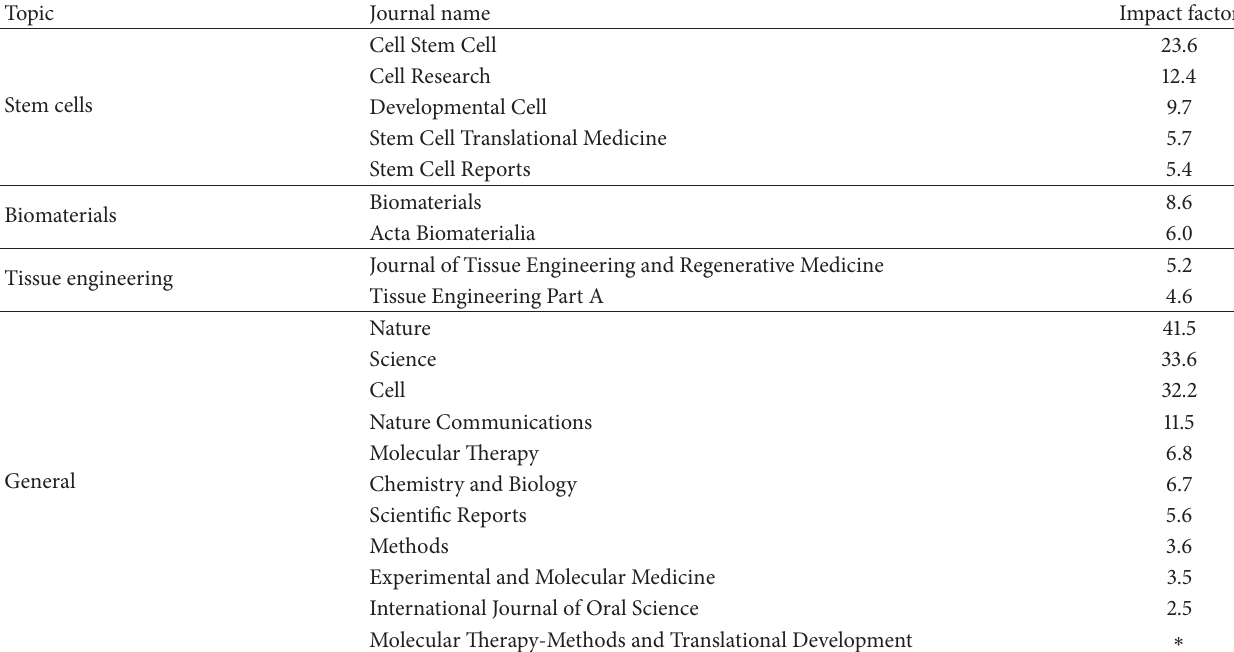
Table 1: Journals that publish regenerative medicine research articles used in this